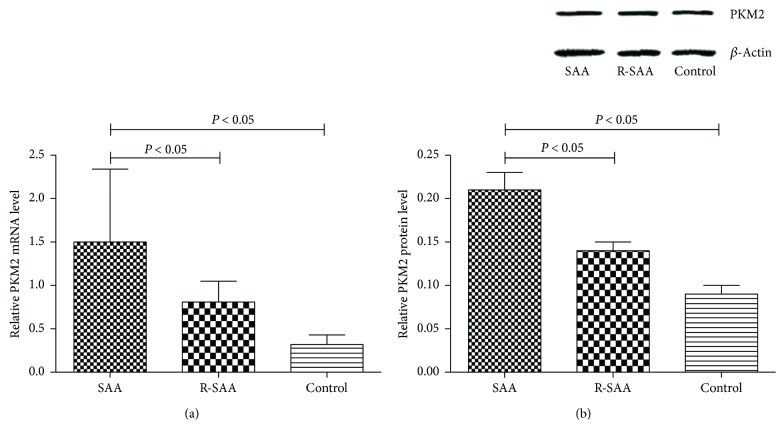
The expression level of PKM2 mRNA and protein by qPCR (a) and western blot (b). Proteins were detected with monoclonal anti-polyhistidine antibodies. We found increased PKM2 expression in untreated SAA patients.